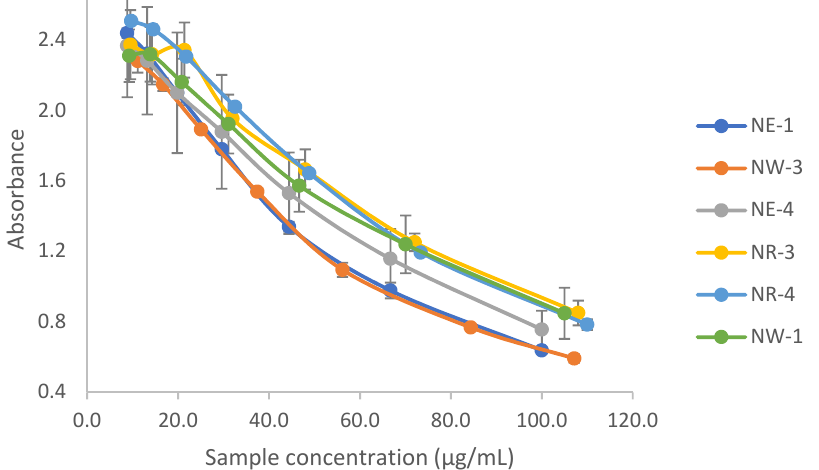
Figure 17. NO scavenging activity of selected samples ( n = 6) of extracts from C. longa rhizomes. Compared with previous results on the effect of curcuminoid extracts from C. longa rhizomes on NO scavenging activity, samples NE-1 and NW-3 are within the range of a reported IC 50 value of 39 µg/mL for turmeric from Slovakia [54]. On the other hand, NO scavenging activity obtained for curcuminoids extracts from rhizomes of other Curcuma species indicated variability in results with IC 50 ranging from 7.18 µg/mL for Curcuma amada [46] and 155 µg/mL for Curcuma caesia [47], therefore all 12 turmeric samples ana- lyzed in the current study present scavenging activity values between these two curcuma species.